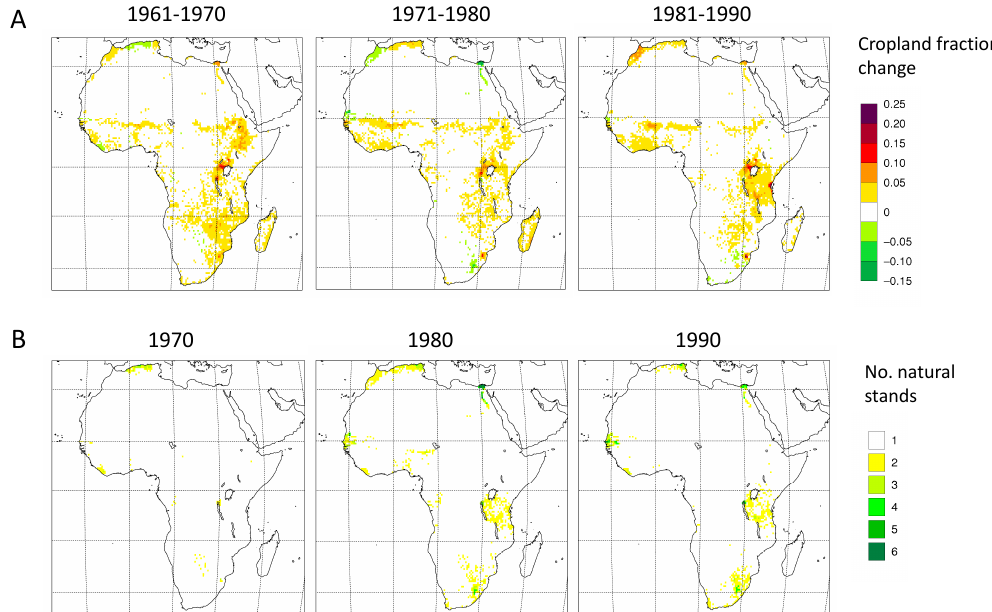
Fig. A3. (A) Cropland fractions for the time periods 1961–1970, 1971–1980 and 1981–1990, derived from Ramankutty and Foley (1999). Green areas represent cropland abandonment. (B) Effect of cropland abandonment on the number of natural vegetation stands in a LPJ- GUESS simulation accounting for land cover change for the years 1970, 1980 and 1990. More than one natural stand is the result of previous years’ cropland